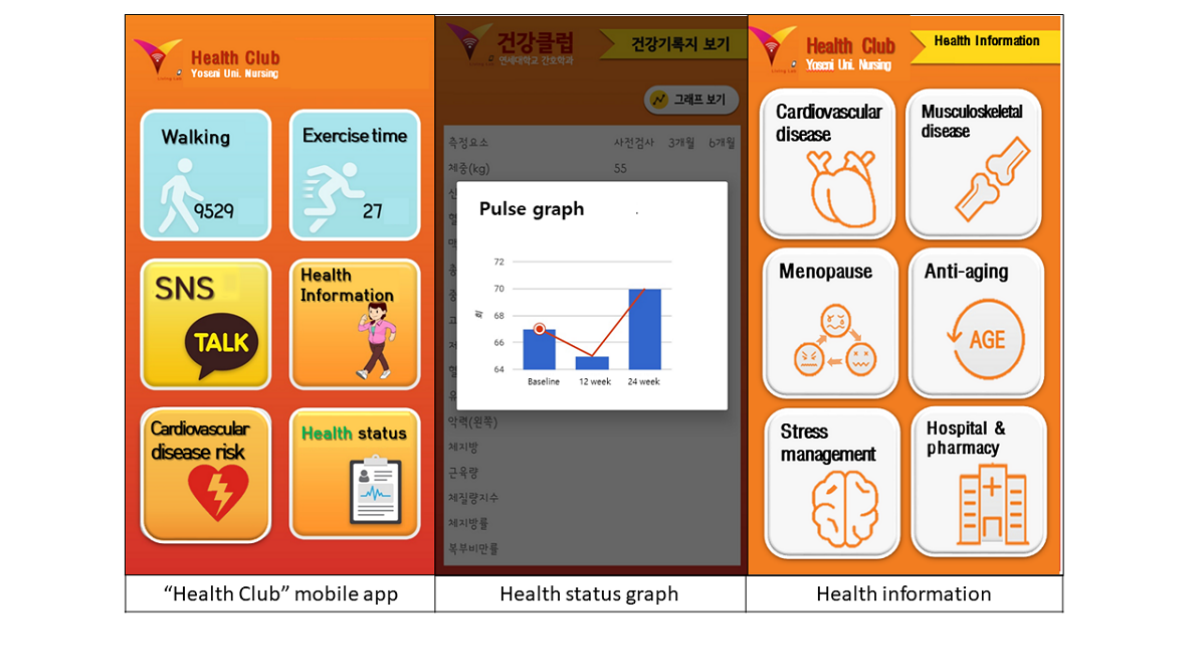
Figure 3. Components of the Health Club mobile